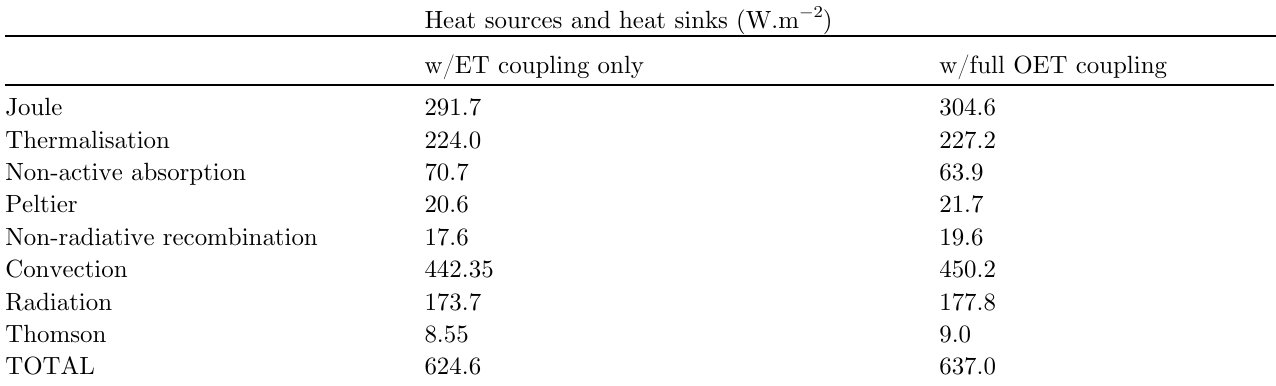
Fig. 4. Current density and cell temperature under short-circuit conditions in different coupling scenarios. In the fi rst scenario ( “ w/o coupling ” ), the solar cell is operating under STC (its temperature is set to 25 ° C). In the second scenario ( “ w/ET coupling only ” ), the thermal module is coupled to the electrical module, but the optical response is calculated assuming a complex refractive index equal to 25 ° C. In the third scenario ( “ w/full OET coupling ” ), all the three physical modules are coupled together. Table 2. Heat sources and heat sinks of the reference cell at short-circuit condition for the electro-thermal (ET) and the opto-electro-thermal (OET) coupling